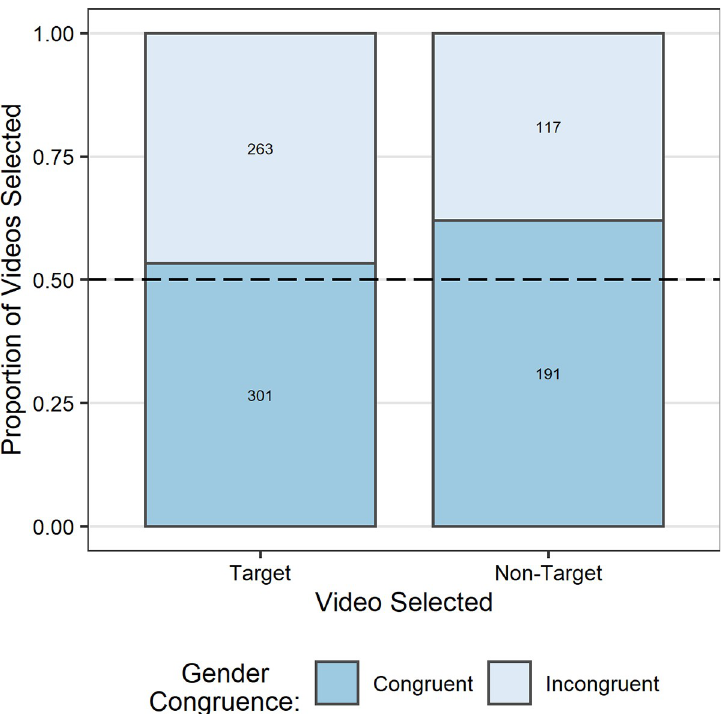
Fig 3. Proportion of target and non-target demonstration video selections ( N = 872) by participant-selected demonstrator gender congruence. Target video selections equate to appropriate information seeking. Values presented on bars refer to the number of trials each proportion represents. Dashed line indicates